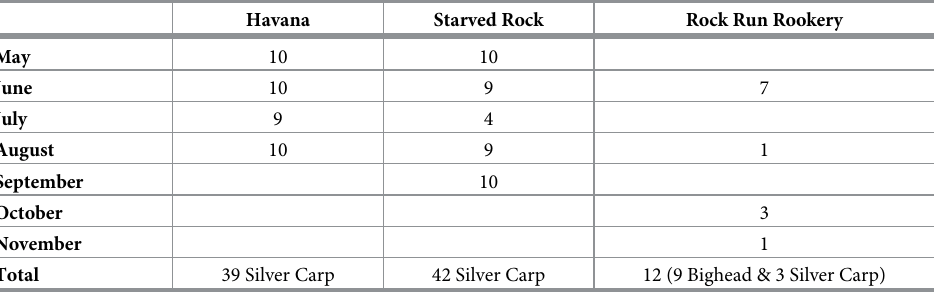
Table 1. A summary of bigheaded carp (silver carp Hypophthalmichthys molitrix and bighead carp H . nobilis) col- lection efforts in the Illinois River across three locations (downstream: Havana, Starved Rock and upstream Rock Run Rookery) between May and November of